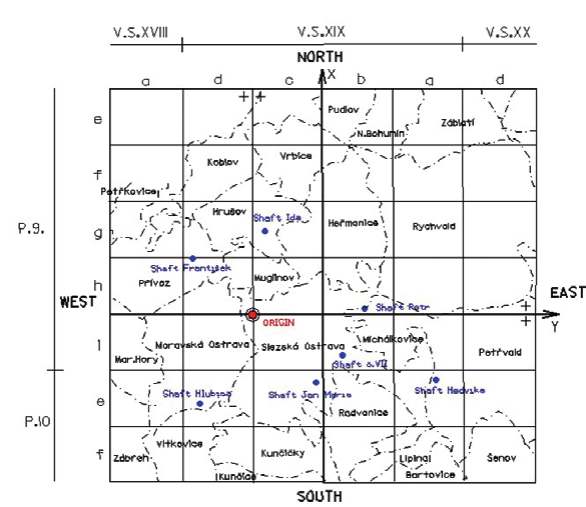
Fig. 2. Ott´s system of coordinates